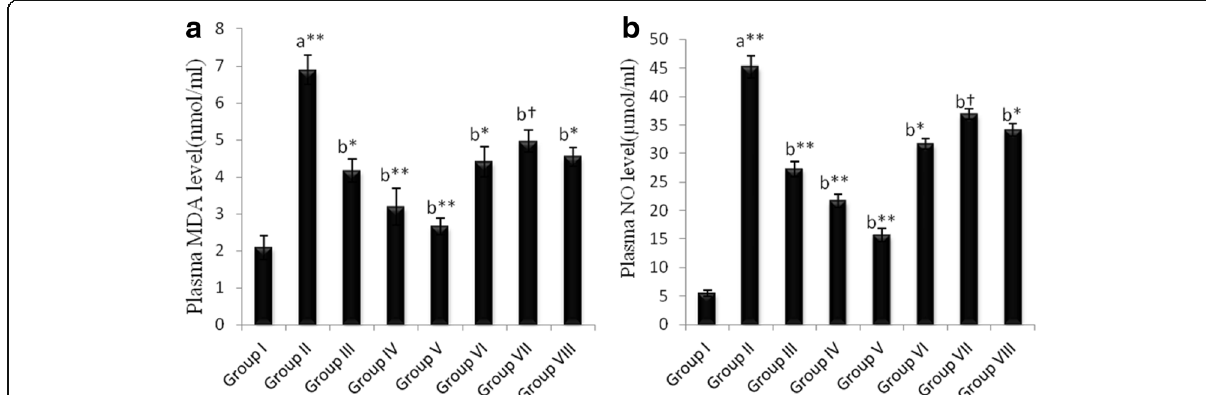
Fig. 8 Effect of E. hirta on plasma malondialdehyde ( a ) and nitric oxide ( b ) levels. Each value is Mean ± S.E.M ( n = 3). (*) indicates statistically significant difference from respective group using ANOVA, followed by Dunnett ’ s multiple comparison test ( ** p < 0.01). ( † ) indicates statistically no significant difference from respective group using ANOVA, followed by Dunnett ’ s multiple comparison test ( p > 0.05). a = when compared with Normal control, b = when compared with diabetic wound control. Group I = normal control, Group II = Diabetic wound control, Group III = Diabetic wound control +100 mg ethanolic extract of E. hirta , Group IV = Diabetic wound control +200 mg ethanolic extract of E. hirta , Group V = Diabetic wound control +400 mg ethanolic extract of E. hirta , Group VI = Diabetic wound control +5% Povidone iodine, Group VII = Diabetic wound control +5% ethanolic extract of E. hirta , Group VIII = Diabetic wound control +10% ethanolic extract of E.